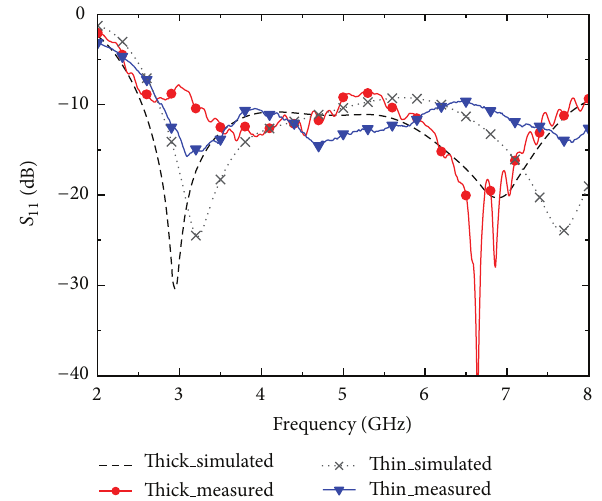
Figure 5: Simulated and measured return losses of the UWB antenna.